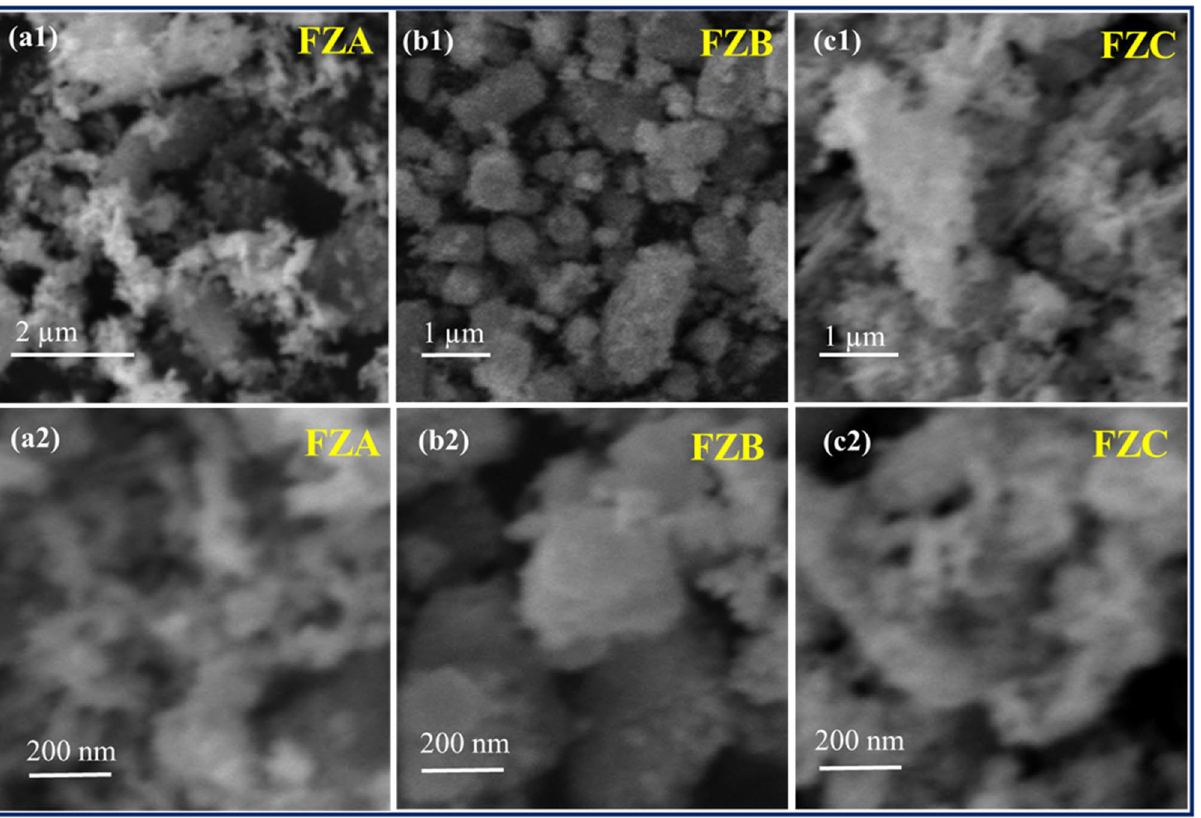
Figure 3. SEM images at low magnification ( a1 – c1 ), and ( a2 – c2 ) at high magnification for the samples FZA, FZB and FZC pattern can be seen at peak 35.4° in FZA and FZB samples at the major peak of Fe 3 O 4 cubic phase as this peak is completely merging with the ZnO peaks positions of 34° and 36°. The deviation at 35.4° is evident in the pres- ence of Fe 3 O 4 cubic phase and its complete merger confirms the formation of excellent composite with uniform completely mixed in ZnO. Also, the peak does not appear abruptly which signifies that multiphase composite will perform efficiently as composite due to effective incorporation of Fe 3 O 4 in ZnO 26 . However, in the XRD pattern of FZC (Fig. 2(c)) the small peak appears abruptly at 35.4°, which corresponds to Fe 3 O 4 major peak (311) and indicates that Fe 3 O 4 is not properly mixed with the ZnO in FZC and appears separately in the nanocomposite. From this we can understand that the use of optimized concentration of Fe 3 O 4 is desired for efficient hybrid material. The crystallite sizes obtained from W–H plots are 9.3 nm (Fe 3 O 4 ), 45 nm (bare ZnO), 42.4 nm (FZA), 41.7 nm (FZB), and 44.7 nm (FZC) 27 . From the XRD patterns, we have observed that the optimized concentra- tion of FN in nanocomposite does not affect the structural properties significantly and appears as a separate phase. It is not mixed with the ZnO matrix which signifies that the composite will show properties of both of the constituents’ particles. Figure 3 shows the SEM micrographs of the FZNCs at low and high magnification to observe the morphology of the samples. Figure 3(a1–c1) depicts the SEM images at low magnification and (a2–c2) at high magnification for the MNC samples. From the SEM micrographs, we can clearly distinguish two differentiable sizes of the par- ticles in all the FZNCs samples. The XRD results confirm that the crystallite size of the FZNCs lies in the range 40–50 nm and Fe